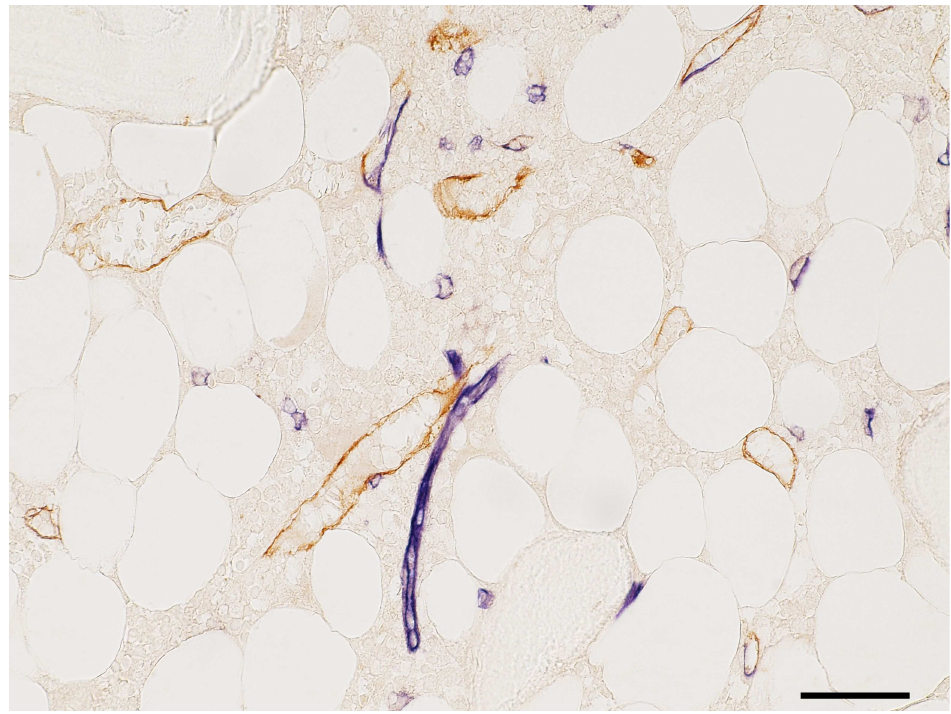
Fig 2. Bone marrow subtractively stained for CD34 (blue) and CD 141 (brown). CD34 is visualisedin small microvesssels (capillaries) and is less intensely expressed in large microvessels (sinuses)which exhibit patchy blue and brown staining.Scale bar = 50 μ